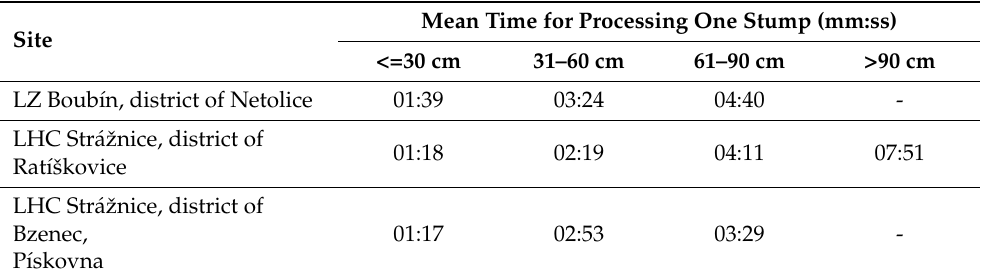
Table 5. Comparison of time for processing one stump at the respective sites by stump diameter.